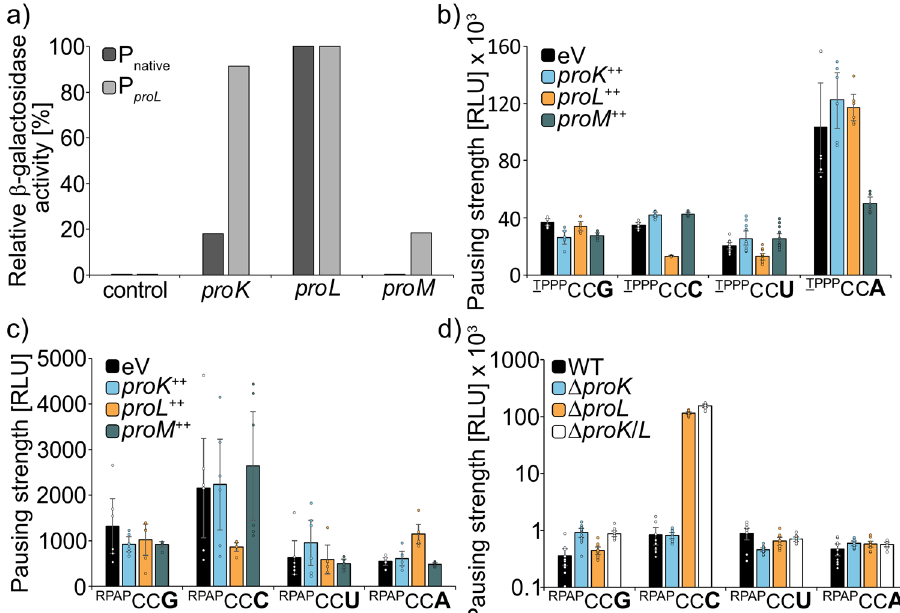
Fig. 6 In fl uence of prolyl-tRNA copy number on the codon-dependent pausing strength at PP-motifs. a Approximation of E. coli BW25113 cells carrying the weak HisL*_Lux operon (TPPP) with different proline codon usage were transformed with pBBR1 MCS4- lacZ plasmids encoding ProK, ProL, or ProM under the control of their corresponding native promoters. n = 4. b E. coli BW25113 cells carrying the weak HisL*_Lux operon (TPPP) were transformed with pBBR1 MCS4- lacZ plasmids encoding for ProK, ProL, or ProM under control of P proL and tested for bioluminescence emission. n = 6. c E. coli BW25113 cells carrying the “ non-PP ” HisL*_Lux operon (RPAP) were transformed with pBBR1-MCS4- lacZ plasmids encoding for ProK, ProL, or ProM under control of P proL and tested for bioluminescence emission. n = 6. d The “ non-PP ” HisL*Lux operon (RPAP) was genomically integrated in E. coli BW25113 deletion strains lacking either proK ( Δ proK ), proL ( Δ proL ), or both ( Δ proK/L ) and cells were tested for bioluminescence emission. n = 12, Error bars indicate 95% con fi dence